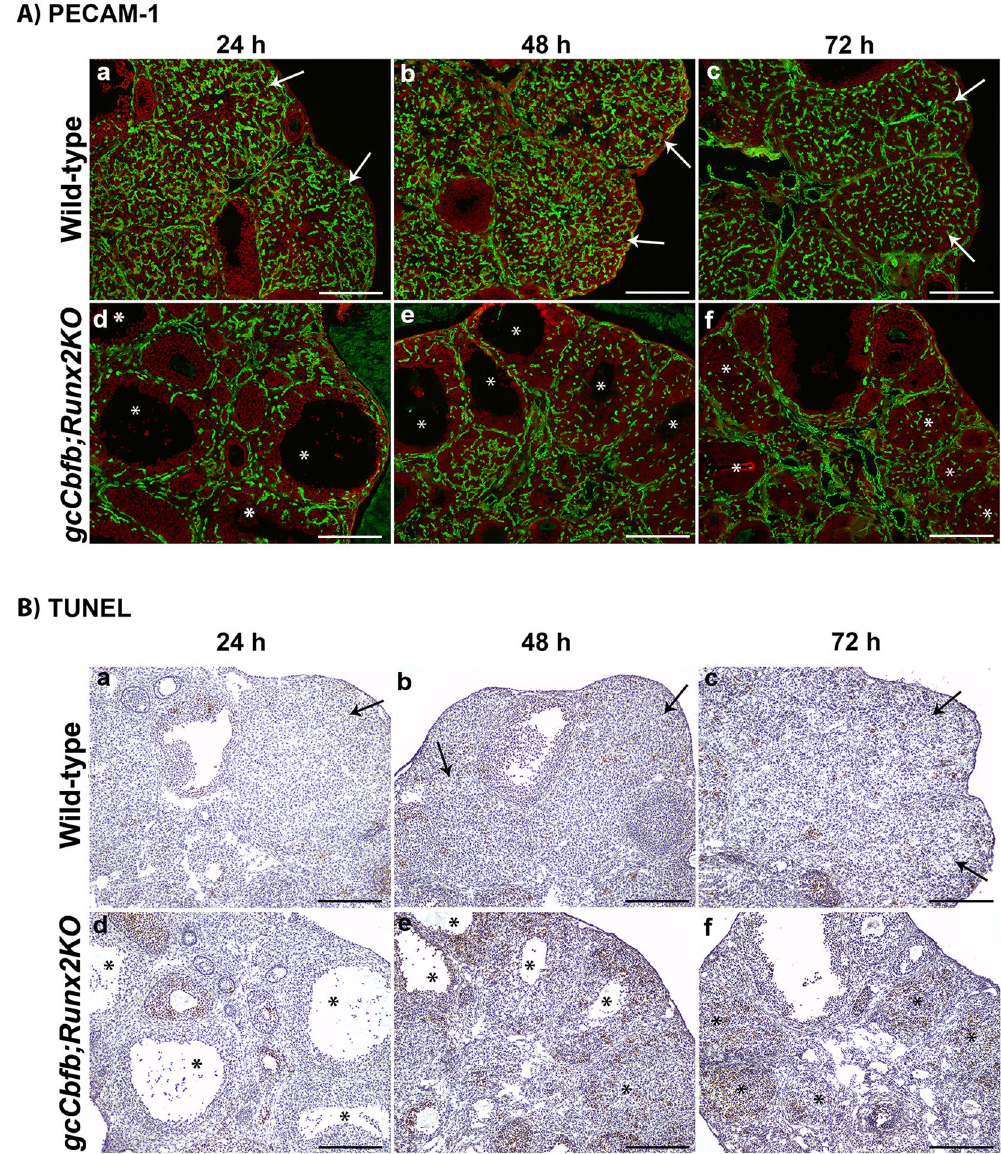
Figure 8. Assessment of vascularization and apoptosis during the post-ovulatory period in gcCbfb;Runx2KO mice. Ovaries were collected at 24, 48, and 72 h after hCG administration (n = 3 animals/ genotype). ( A ) Immunohistochemical analysis was used to detect PECAM-1 (green fluorescence staining). The ovarian sections were counterstained with propidium iodide (red). ( B ) TUNEL assay was used to detect apoptotic cells (brown staining). The ovarian sections were counterstained with hematoxylin (blue). Arrows point to CLs in control animals and the symbol ( * ) was placed in unruptured follicles and poorly luteinized collapsed follicles in gcCbfb;Runx2KO mice. Scale bars, 250 μ m for all the